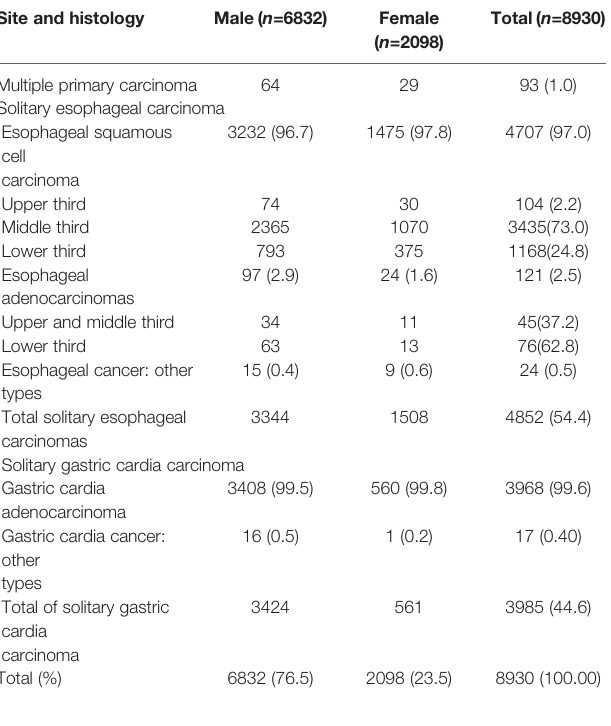
TABLE 2 | Decreasing family history, increasing median age at onset, and male/female sex ratio associated with 8768 patients a with esophageal squamous cell carcinoma and/or gastric cardia adenocarcinoma according to multiplicity, tumor site, and histology. Multiplicity, site, and